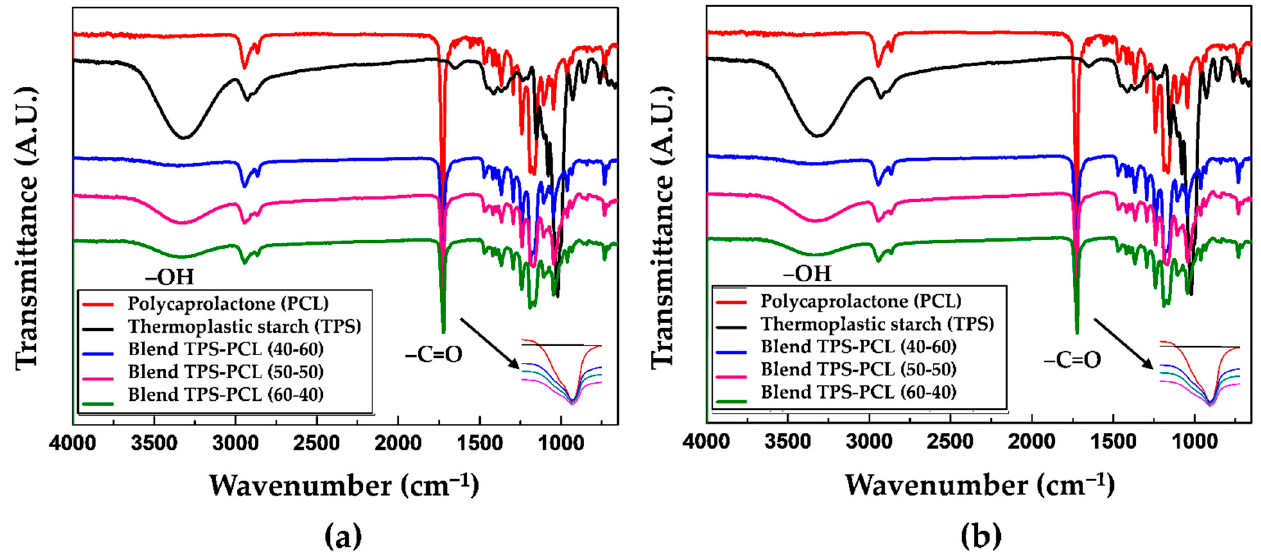
Figure 1. Fourier transform infrared spectroscopy (FTIR) for the polycaprolactone (PCL), thermoplastic starch (TPS), TPS/PCL 40/60 binary blend, TPS/PCL 50/50 binary blend, and TPS/PCL 60/40 binary blend, conditioned at: ( a ) 54% and ( b ) 29%. Table 1. Characteristic bands and type of bond for the TPS/PCL binary blend (50/50). Functional Group/Assignment